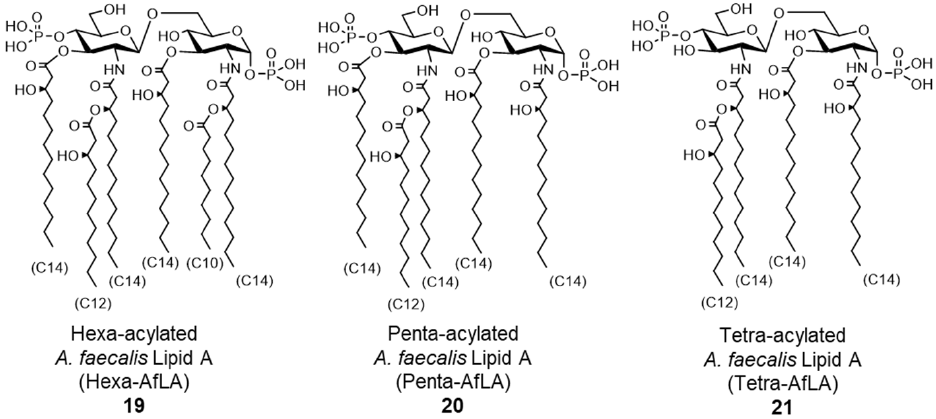
Figure 9. Chemical structures of synthesized A. faecalis lipid As.